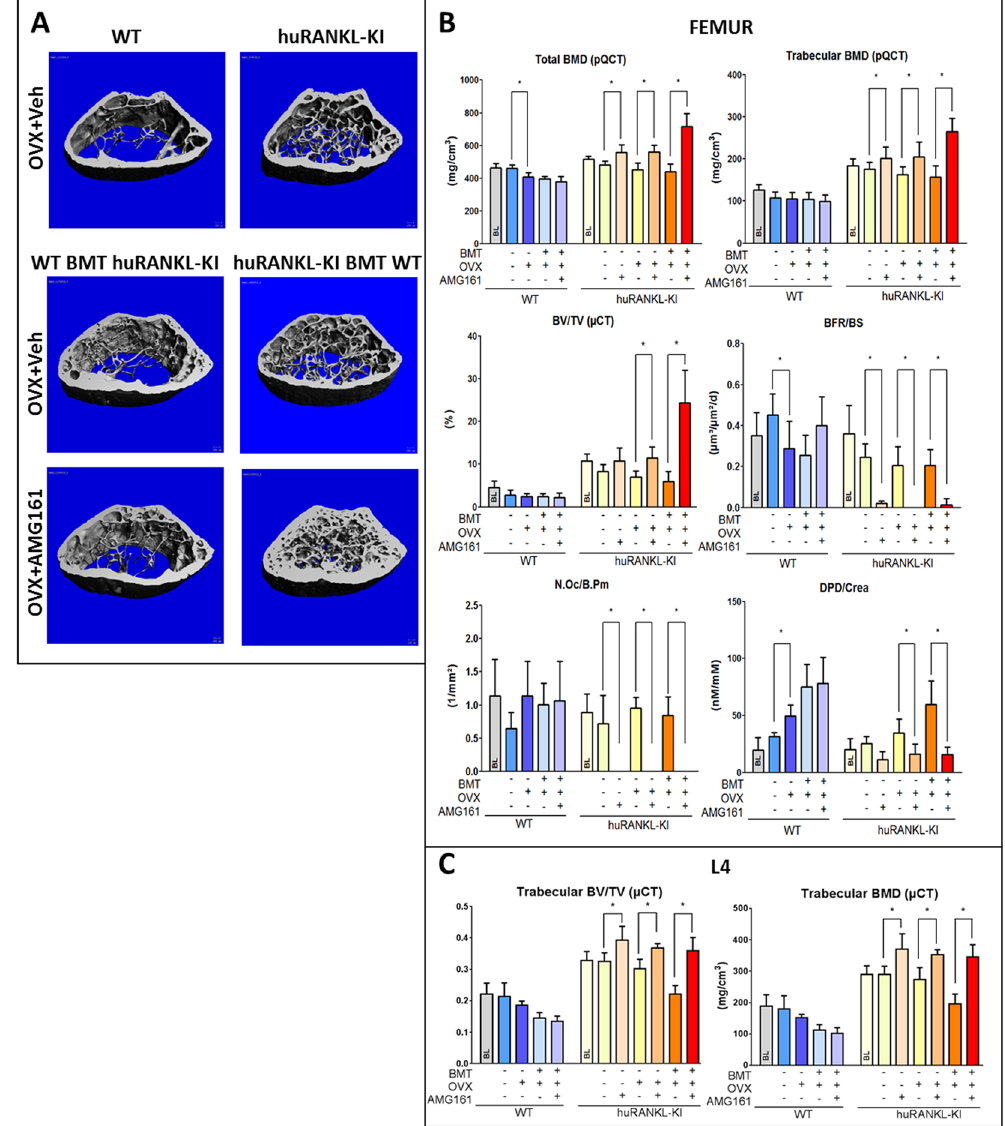
Figure 2. Selective inhibition of RANKL in the hematopoietic or mesenchymal compartment. ( A ) µ CT images of the distal femoral metaphysis of non-irradiated vehicle-treated OVX WT and huRANKL-KI mice (upper panels), and vehicle- or AMG161 (10 mg/kg twice weekly)-treated WT and huRANKL-KI mice transplanted (BMT) with unfractionated bone marrow cells from huRANKL-KI or WT mice, 4 weeks post-OVX. ( B ) Total and trabecular BMD measured by pQCT, bone volume (BV/TV) measured by µ CT, and bone formation rate (BFR/BS) and osteoclast number (N.Oc/B.Pm) measured by histomorphometry in cancellous bone of the distal femoral metaphysis, urinary deoxypyridinoline/creatinine (DPD/Crea) excretion measured by ELISA, and ( C ) bone volume (BV/TV) as well as trabecular BMD of the L4 vertebrae in non-irradiated and reconstituted WT and huRANKL-KI mice treated with vehicle or AMG161, 4 weeks post-OVX. All irradiated mice were supplemented with physiological doses of E2 during the 4-week recovery phase post-transplantation. Data represent mean ± SD of 8–10 animals each. * Denotes p < 0.05 by one-way ANOVA followed by SNK